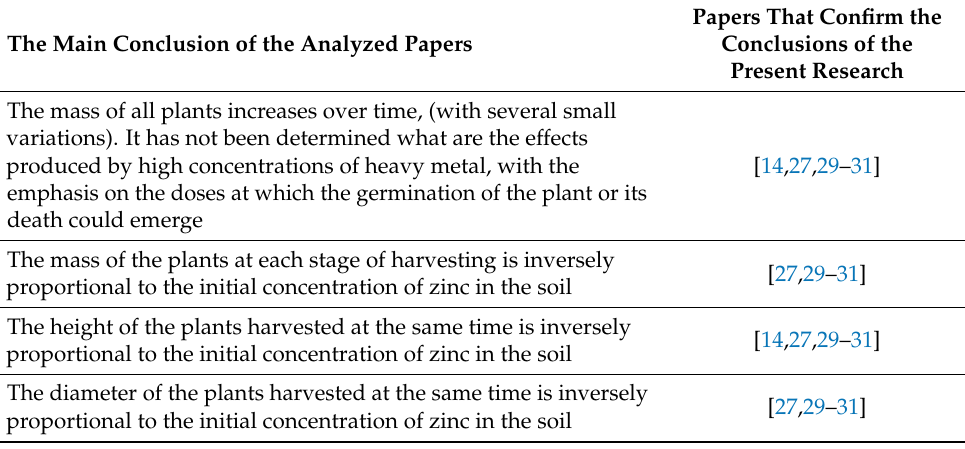
Table 9. Table summarizing key findings for the development of Brassica junceea in similar